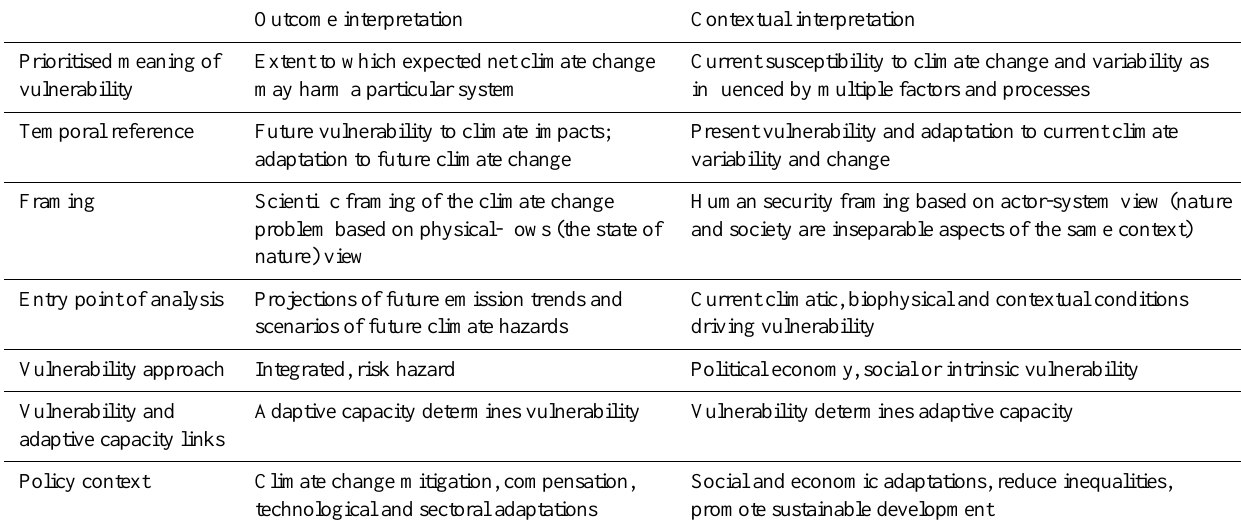
Table 1. Interpretations of vulnerability in climate change impact studies (based on Füssel and Klein, 2006; Füssel, 2007; Kelly and Adger, 2000; O’Brien et al., 2004,